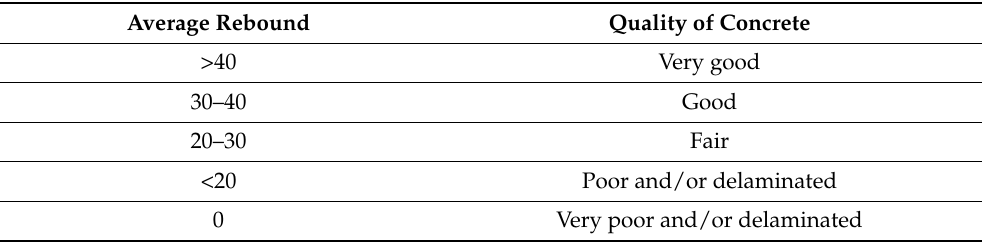
Table 4. Comparative hardness of concrete by rebound hammer test.